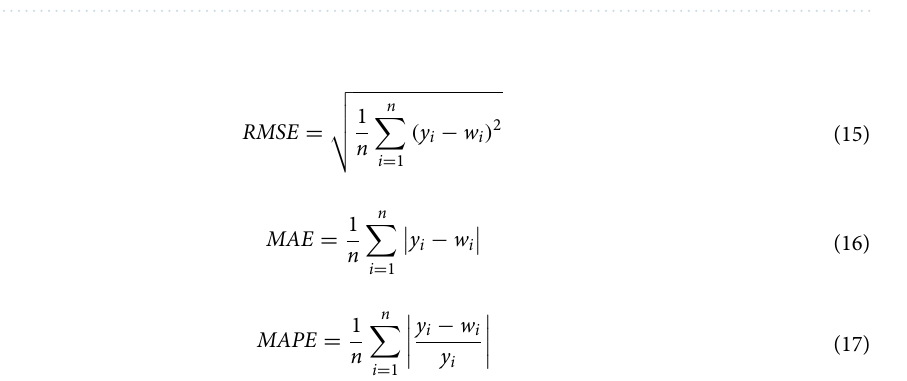
Table 7. Monitoring qualification rate of six types of air pollutant concentrations between self-built points, model forecast values and national control